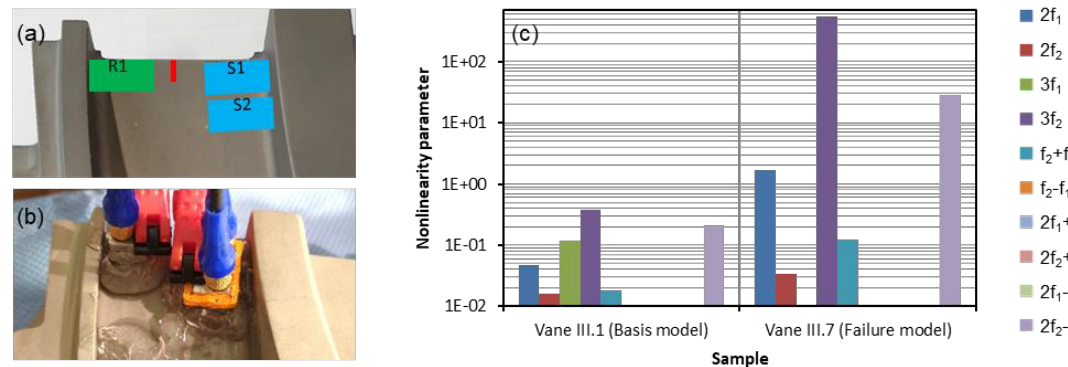
Figure 31. Nonlinearity parameter, opposite sensor orientation, f 1 = 4 MHz, f 2 = 5 MHz: ( a ) Sensor orientation; ( b ) Experimental setup; ( c ) Comparison of nonlinearity parameter.